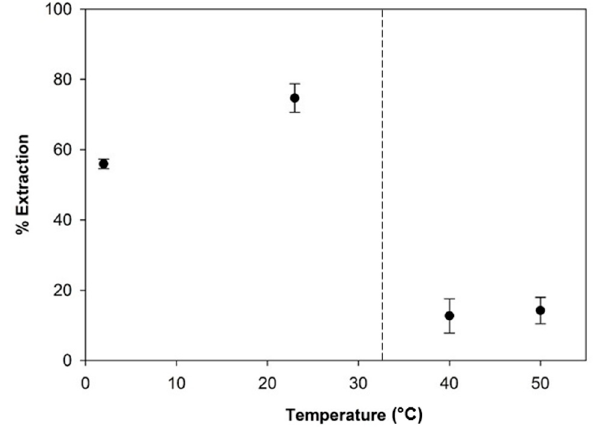
Figure 6. The percent extraction of Eu from a 1000 mg/kg in 8 M HCl solution with TBDGA in CO 2 modified with 2 mol% 1-octanol as the temperature is varied from 2 ◦ C–50 ◦ C at 34.5 MPa. At temperatures less than 31 ◦ C CO 2 is a liquid, and above 31 ◦ C the CO 2 is in the supercritical phase. This point is shown with a dotted line.